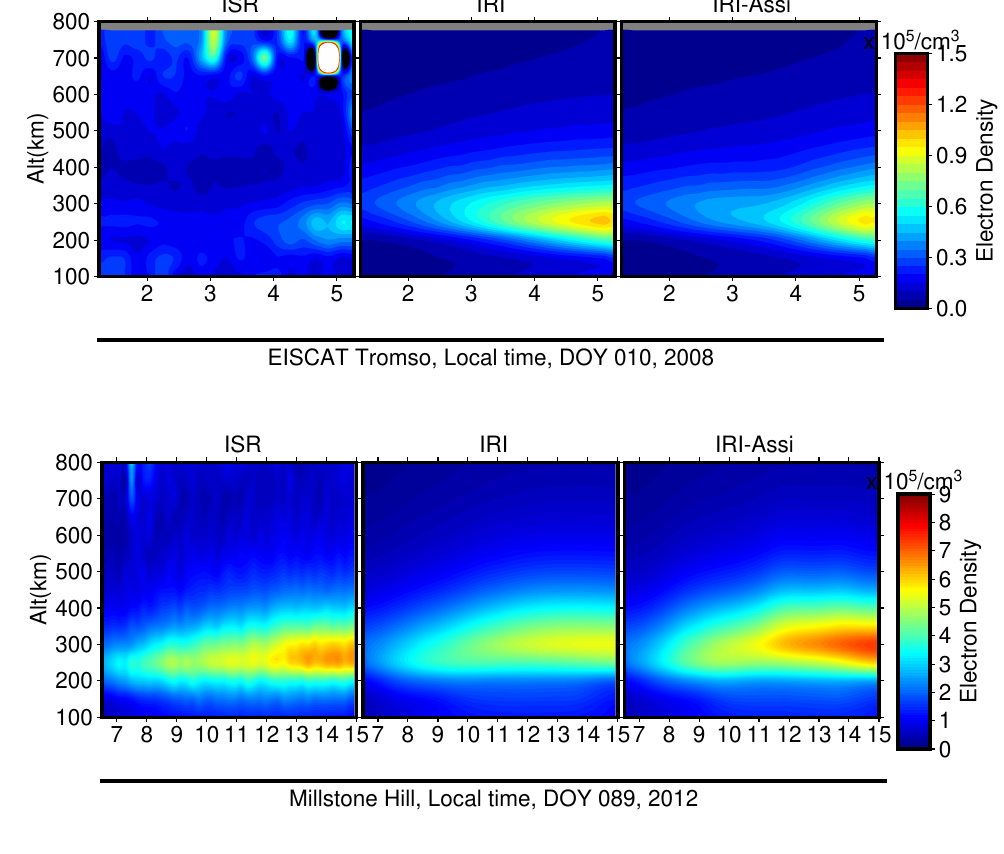
Figure 12. Densities of the ISR and ionospheric